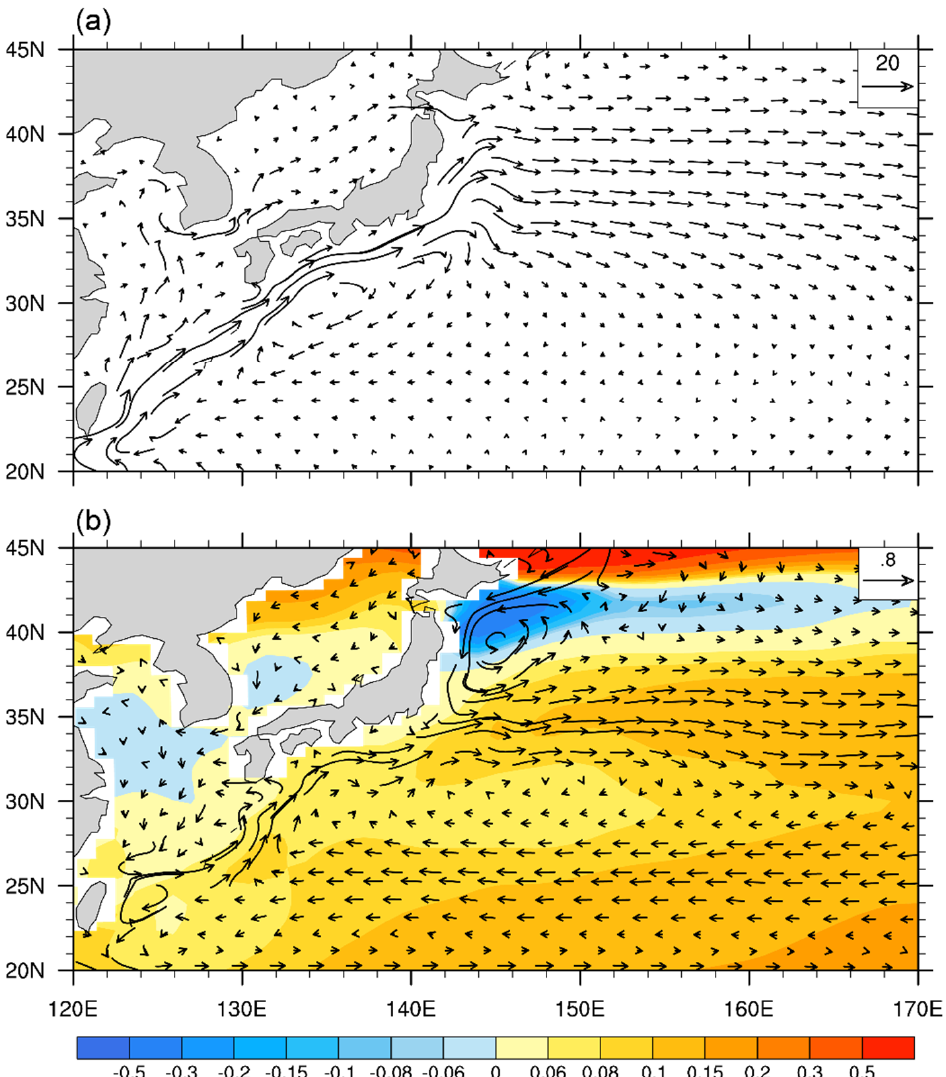
Figure 4. ( a ) Climatological ocean currents averaged in the upper 100 m depth of the North Pacific in FOM. ( b ) The quasi-equilibrium responses of ocean currents averaged in the upper 100 m depth (vectors, cm/s) and SST (color shading, ℃ ) to Arctic sea ice loss in FOM.